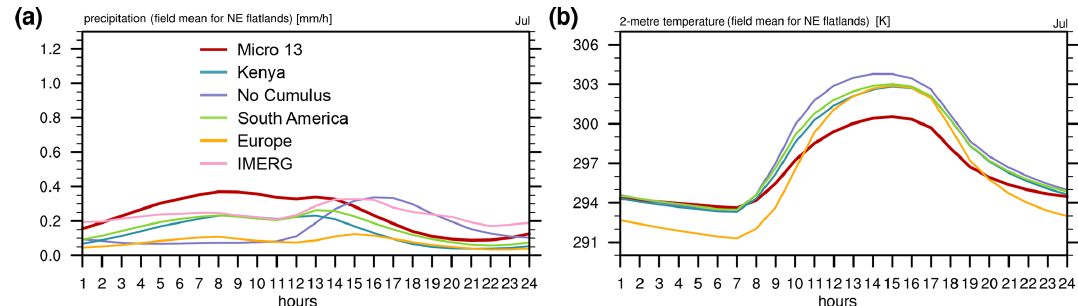
Figure 9. Daily cycle for July of a field mean over the northeastern flatlands for (a) precipitation (mm), and (b) 2m temperature (K). Daily cycle of precipitation (a) also includes IMERG, depicted with a pink line. The x axis shows the hours of the day, shifted by 5h from UTC to show local Peru